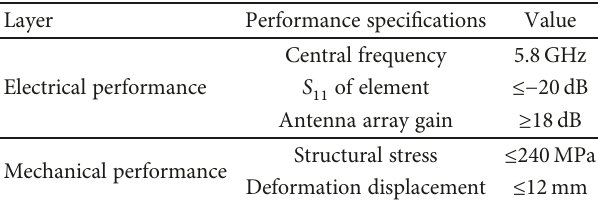
Table 1: Performance requirements of the skin